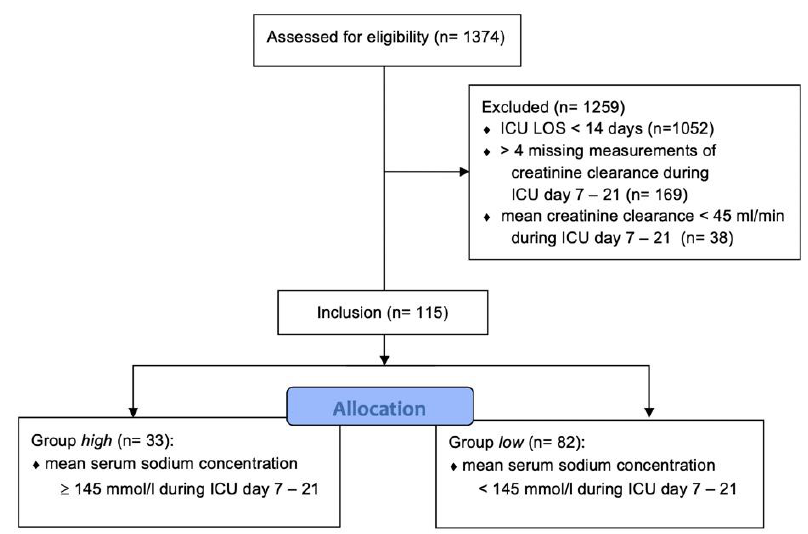
Figure A1. Inclusion criteria, steps of exclusion and group allocation.